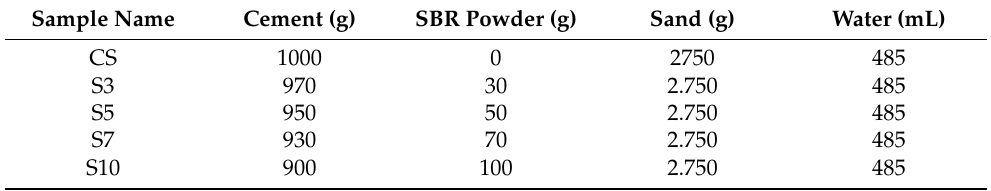
Table 6. Sulfate Resistivity Test: Mix Proportions and Expansions (ASTM C490 and ASTM C1012).